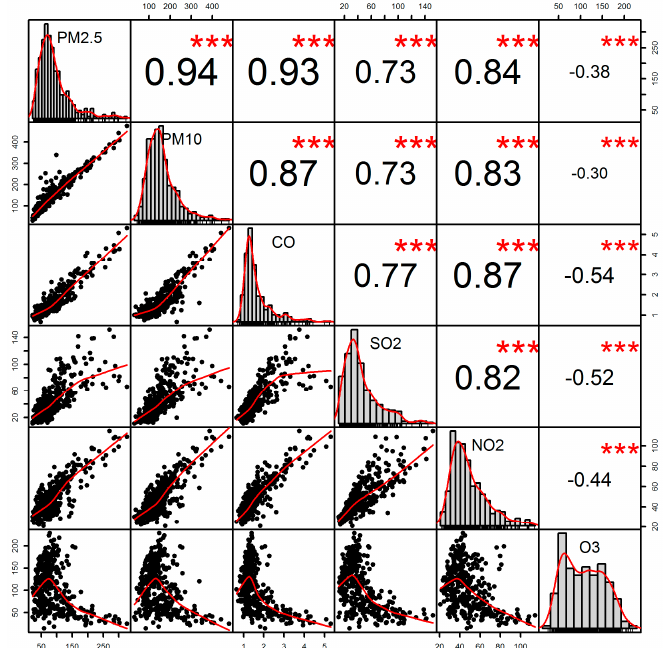
Figure 8. The relationships among the principal air pollutants in the most polluted cities (2015). All the numbers and red stars represent the correlation coefficients and significant relationships among the principal air pollutants.